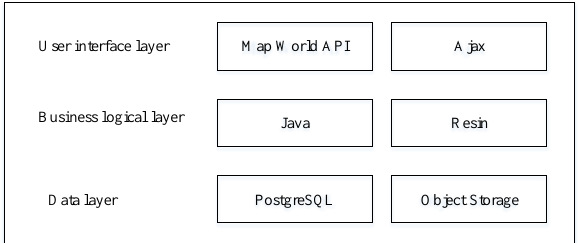
Figure 2. The architecture of the